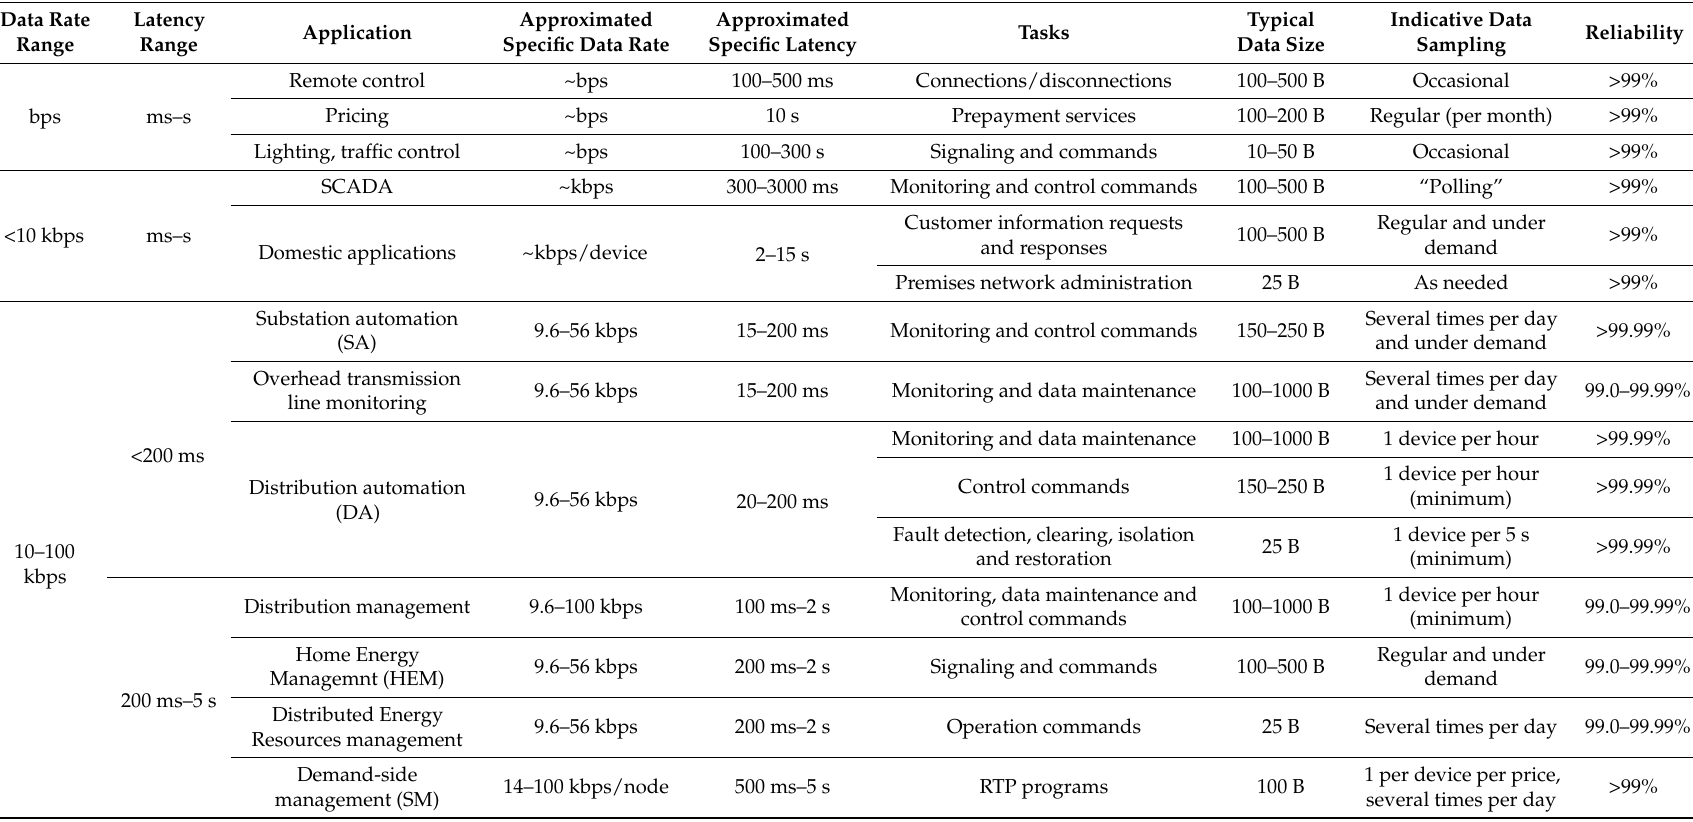
Table 1. Classification of applications for the Smart Grid according to their communication